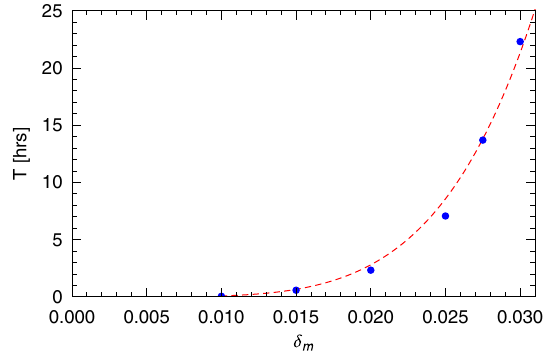
FIG. 15. Touschek lifetime T vs (global) momentum accep- (blue symbols). The dashed curve gives the tance parameter, (cid:8) m